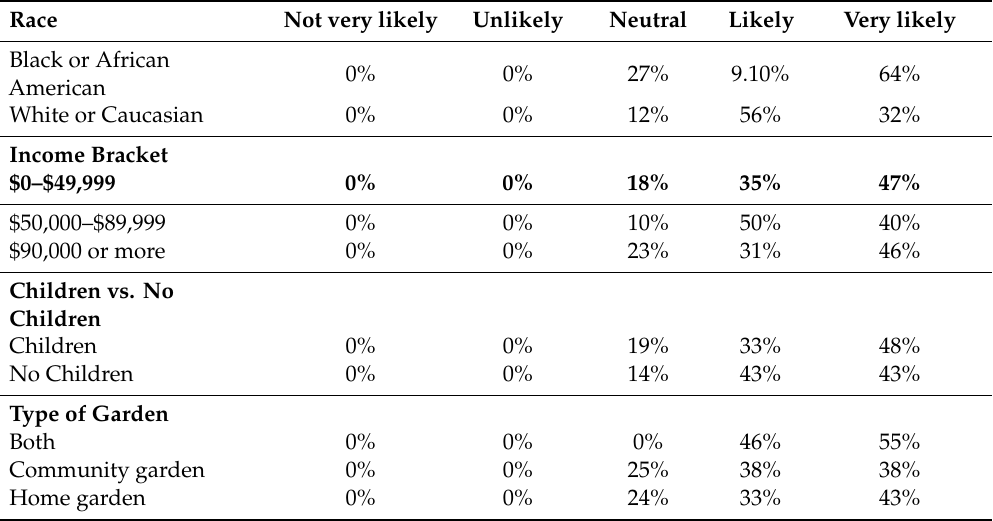
Table A14. Likelihood of participants taking action to remove heavy metal soil contaminants if made aware of